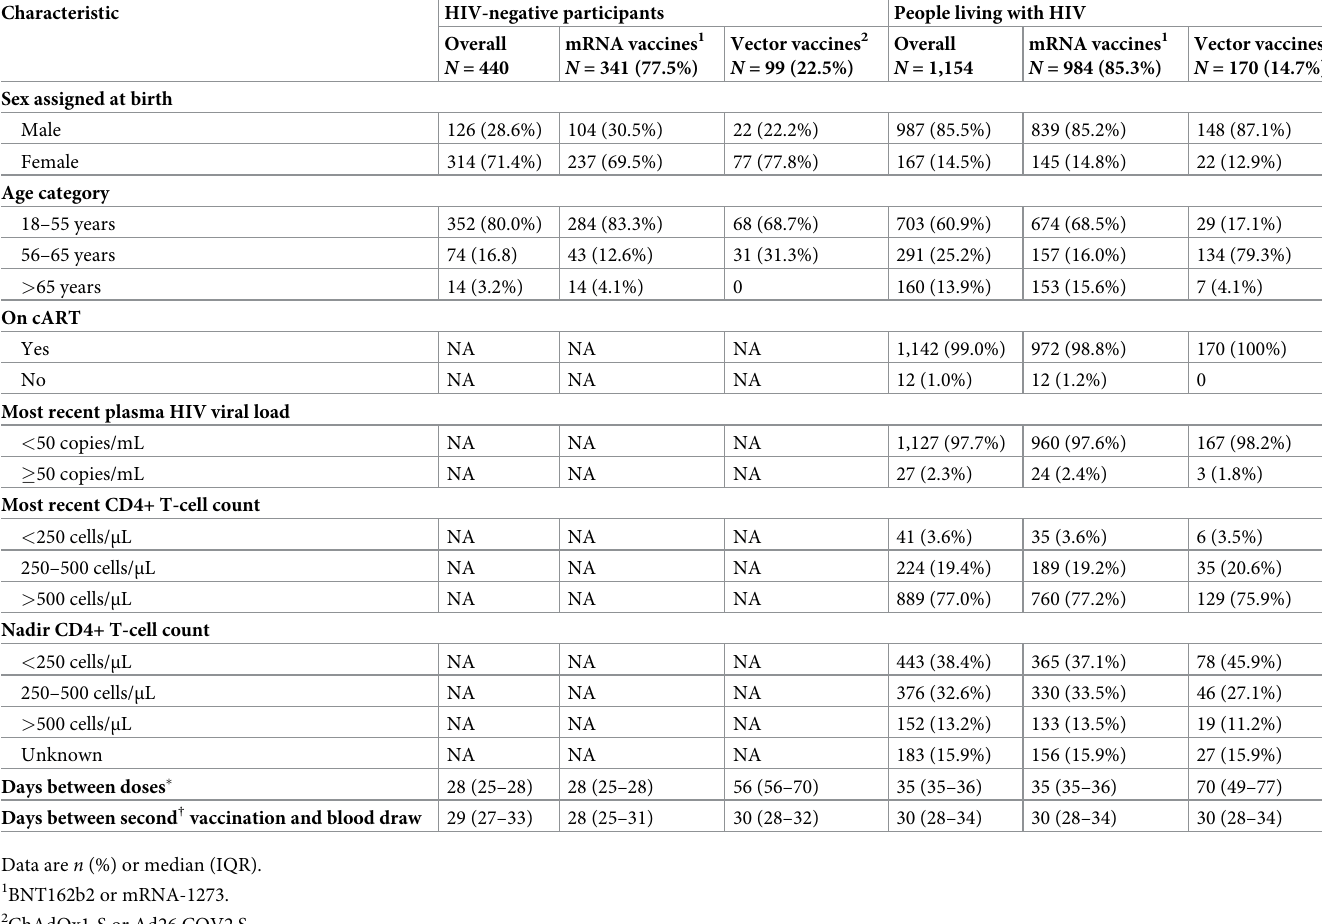
Table 1. Baseline characteristics of HIV-negative controls and